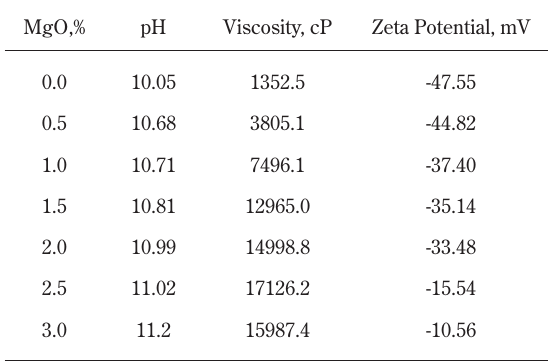
Table 7 pH, viscosity and zeta potential values of